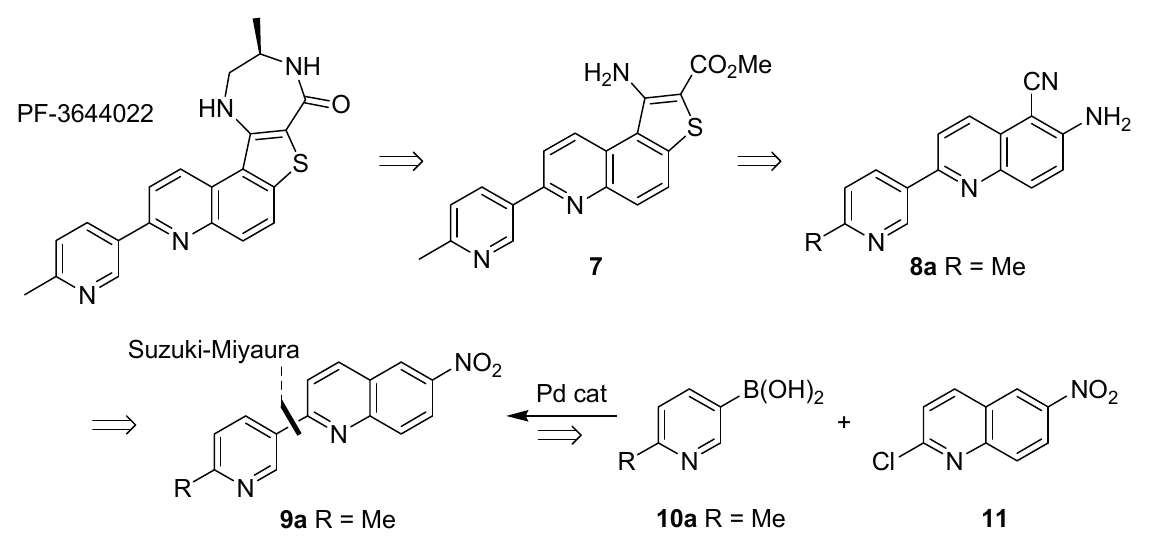
Figure 5. Disconnective approach to the synthesis of PF-3644022, utilizing an early-stage Suzuki-Miyaura cross-coupling